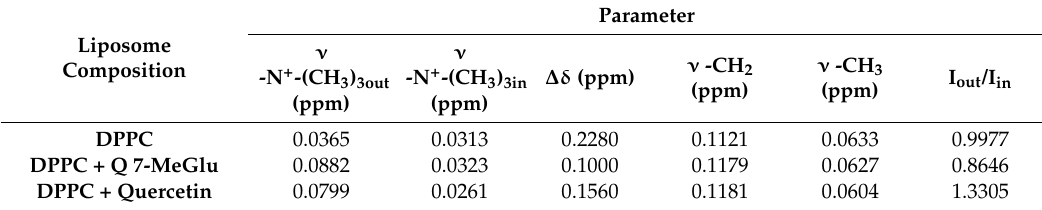
Table 2. Parameters of 1 H-NMR spectra at 325 K of DPPC liposomes and DPPC liposomes with addition of quercetin 7- O - β - D -(4”- O -methyl)glucopyranoside (Q 7-MeGlu) and quercetin (Q) at